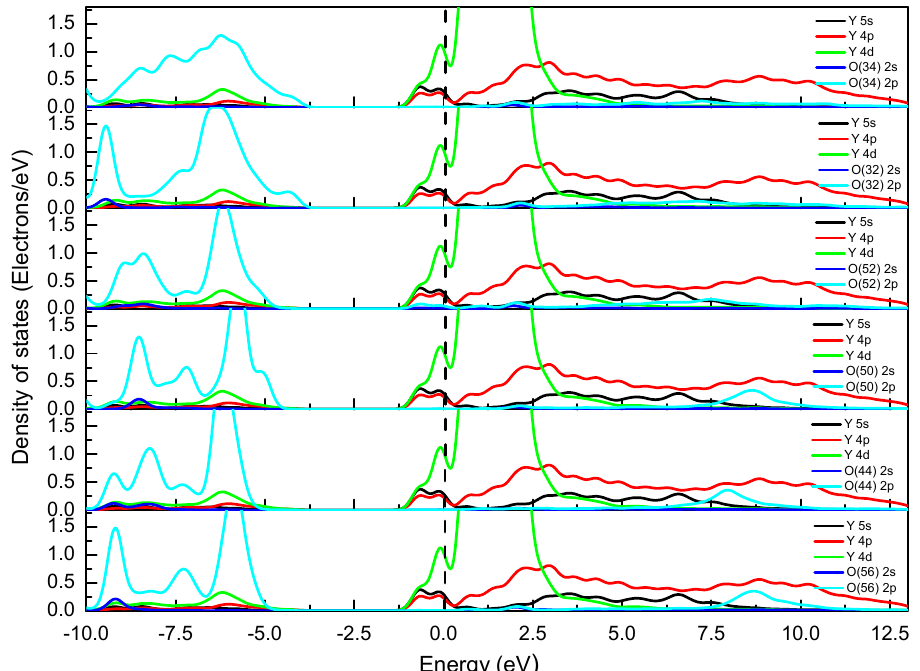
Figure 5. Partial density of states of Y and O in (Al-OH)-H 2 O interface.